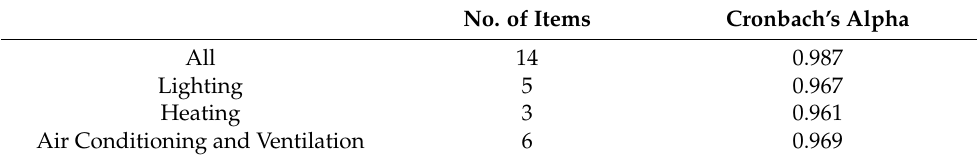
Table 3. Reliability and validity